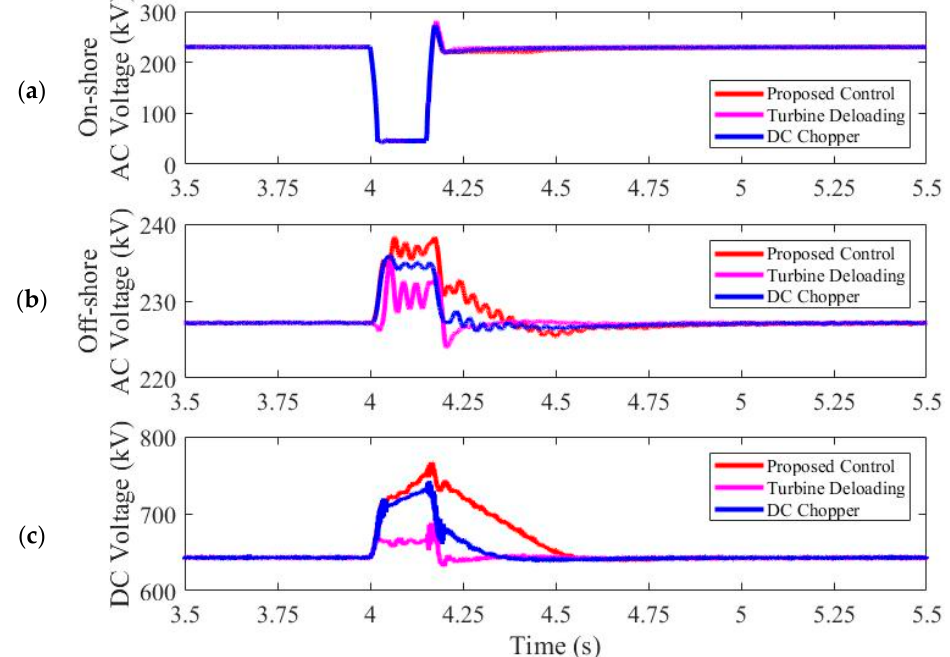
Figure 10. Simulation results of the on-shore fault scenario with a 2.95 Ω fault resistance. ( a ) On-shore AC voltage for each simulation case. ( b ) Off-shore AC voltage for each simulation case. ( c ) Rectifier-side DC voltage for each simulation case.